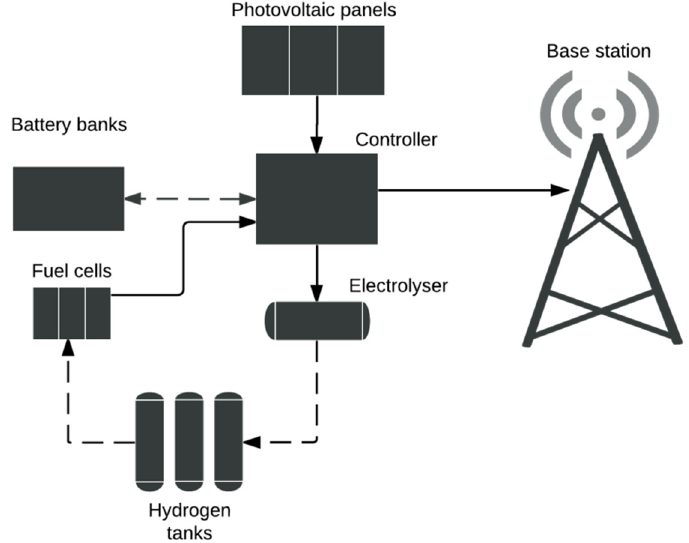
Figure 7. An example of a hybrid energy storage system ( i.e. , batteries and hydrogen system) application present in a PV-hydrogen/battery system for off-grid base